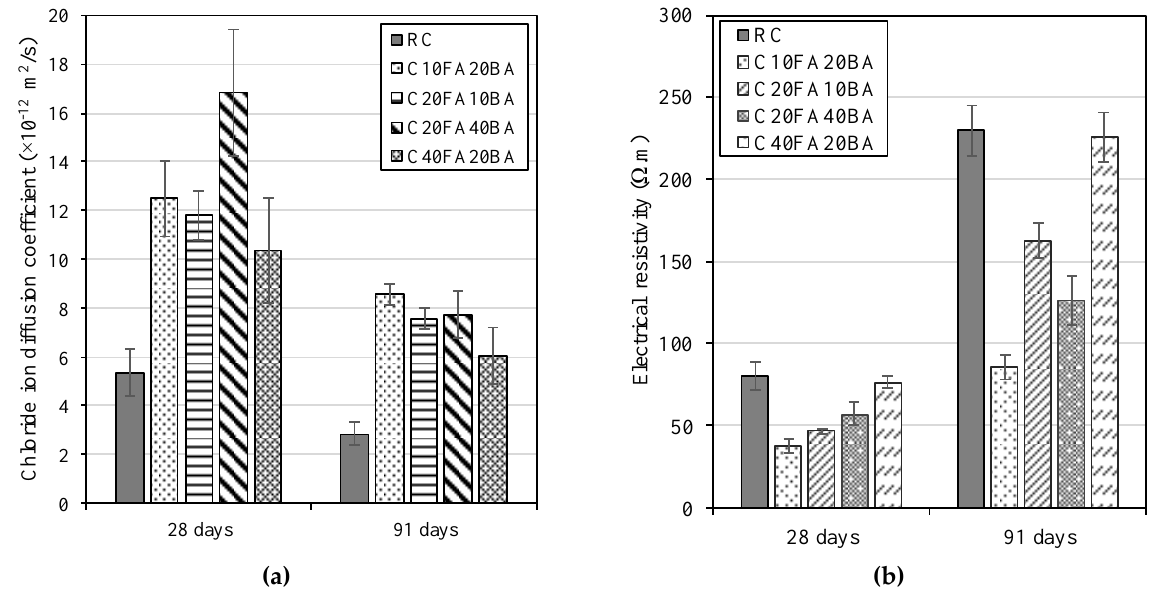
Figure 12. Chloride diffusion coefficient ( a ) and electrical resistivity ( b ) at 28 and 91 days.